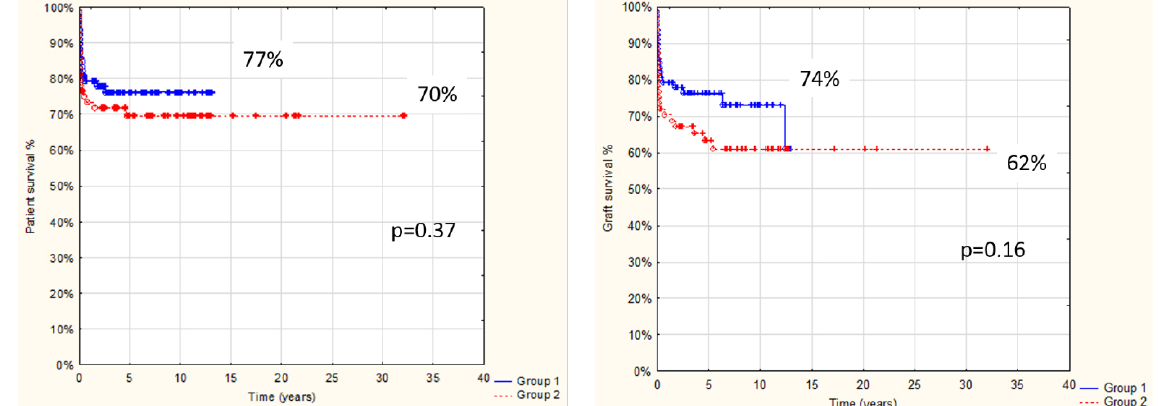
Figure 5. Patient and graft survival; comparison of children after AB0i LT aged ≤ 1 yr (Group 1) and older (Group 2). After transplantation, the only differences occurred in the rates of intrahepatic biliary stenosis and re-transplantation, both more common in Group 2. There was no significant difference in the rate of rejection, or patient or graft survival between the two groups, but more children survived due to re-transplantation among patients older than one year (Tables 2 and 3, Figure 5) Table 2. Results of AB0i LT—comparison of recipients ≤ 1 yr of age and older. Data corrected for availability (removal of missing